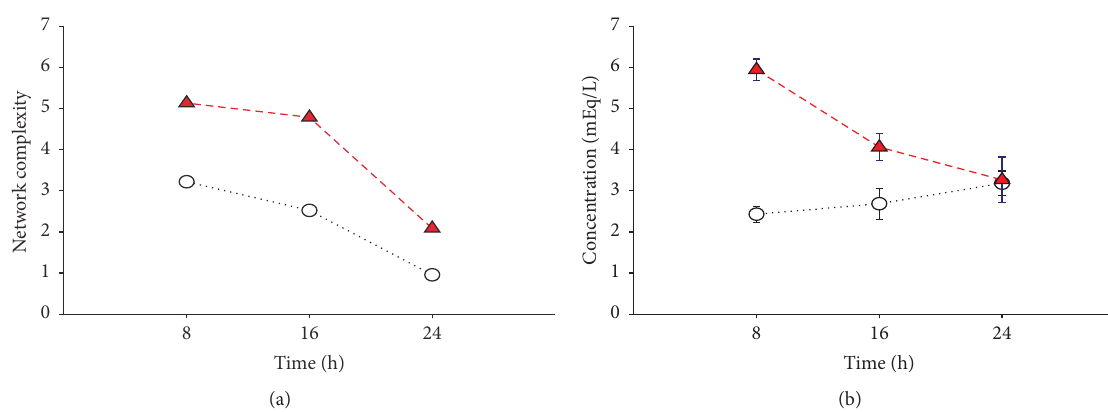
Figure 6: (a) Network complexity differs between the BD ≥ 4 and BD < 4 subgroups over the first 24 h after injury. The BD ≥ 4 group exhibited a higher network density at 8 h and 16 h after injury which progressively decreased to similar levels of BD < 4 group at 24 h after injury. (b) Arterial BD levels within 24 h after injury. BD levels in both BD ≥ 4 and BD < 4 subgroups mirror the density of their corresponding inflammatory